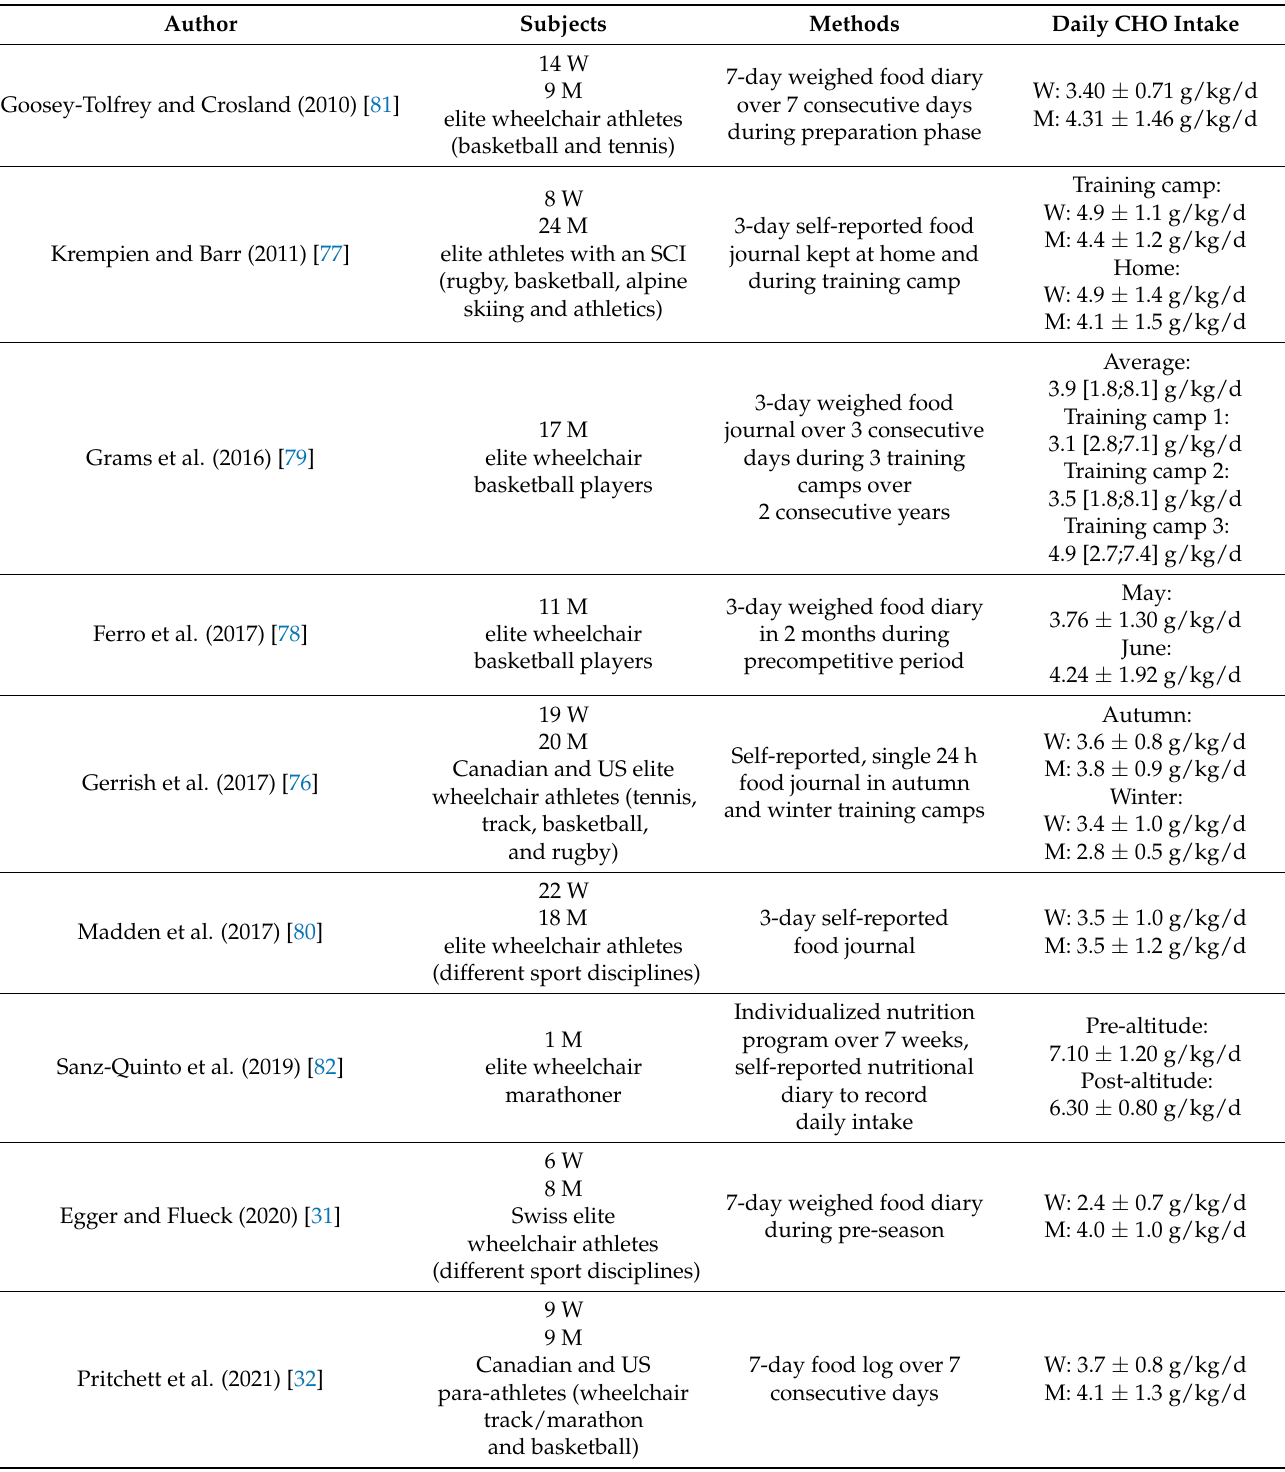
Table 2. CHO intake in athletes with an